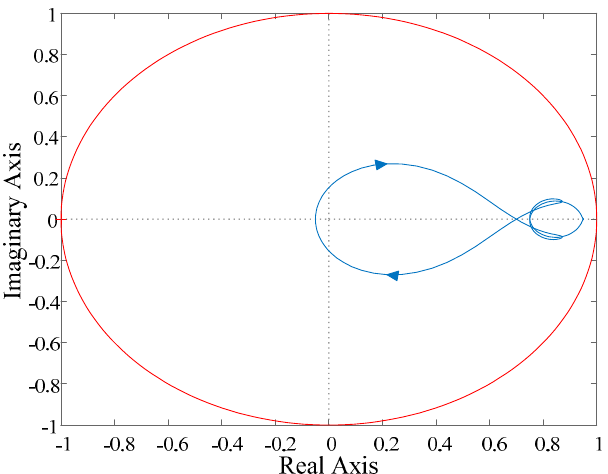
Figure 18. Nyquist diagram of stability criterion H(z) of modified hybrid controller with capacitance load.